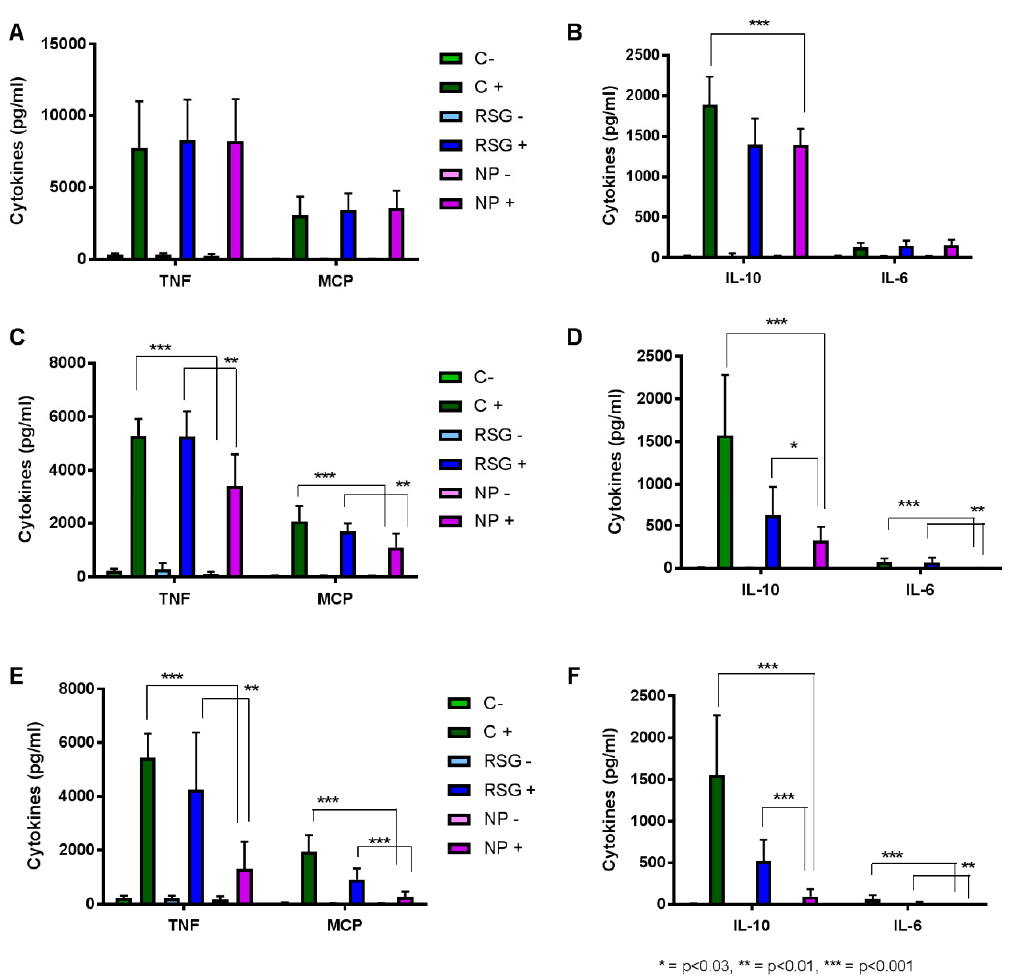
Figure 4. TNF, MCP ( A , C , E ), IL-10, and IL-6 ( B , D , F ) concentrations in supernatants of RAW264.7 cells after 24 h exposure to cell medium (C-), 0.1 µ g/mL LPS (C+), free RSG (RSG-), free RSG and LPS (RSG+), NPs (NP-), NPs and LPS (NP+). Rosiglitazone and corresponding NP concentrations are 7.6 µ M ( A , B ), 59 µ M ( C , D ), 227 µ M ( E , F ).